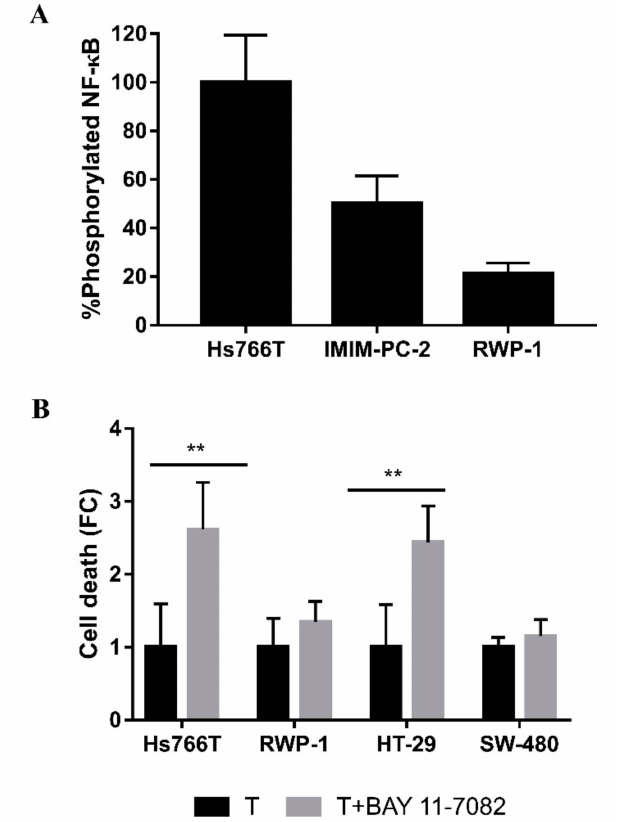
Figure 6. Role of NF- κ B in the resistance to CLytA-DAAO-induced cell death. ( A ) Hs766T, IMIM-PC-2 and RWP-1 cell lines were treated with CLytA-DAAO and D-Ala for 1 h and NF- κ B phosphorylation was determined by ELISA assay. Data represent the percentage of NF- κ B phosphorylation, normalized with respect to Hs766T ± SD with n ≥ 3. ( B ) Hs766T, RWP-1, HT-29 and SW-480 cell lines were treated for 24 h with CLytA-DAAO and D-Ala (T) in the presence or absence of BAY 11-7082, an NF- κ B inhibitor, and cell death was determined by flow cytometry. Data represent the cell death increase after NF- κ B inhibition, normalizing the treatment with CLytA-DAAO as 1 ± SD with n ≥ 3. ** indicates a p -value <